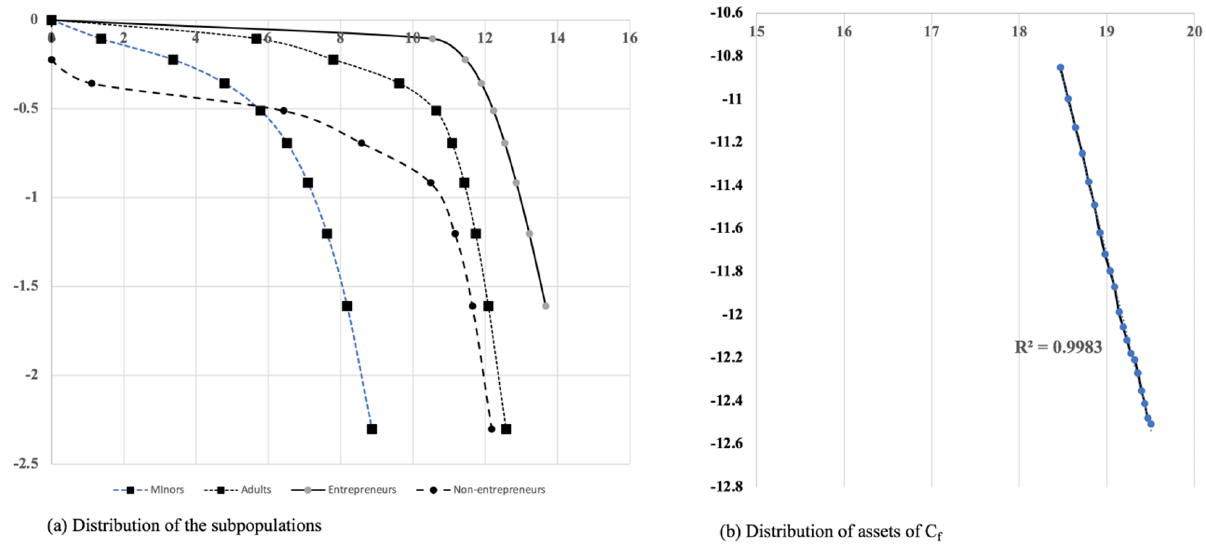
Figure 7. Behavior of subpopulations and large